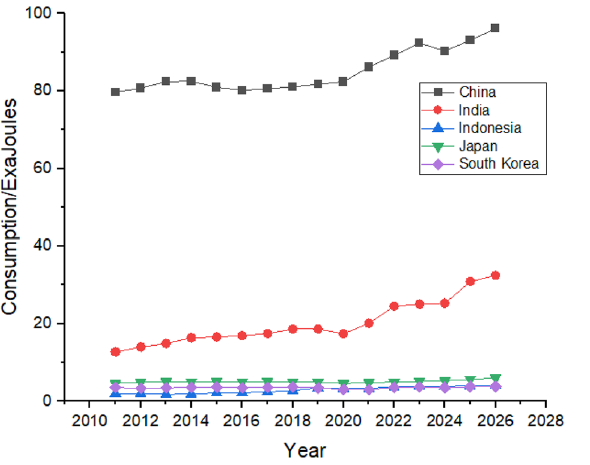
Figure 24. Coal consumption in Asian